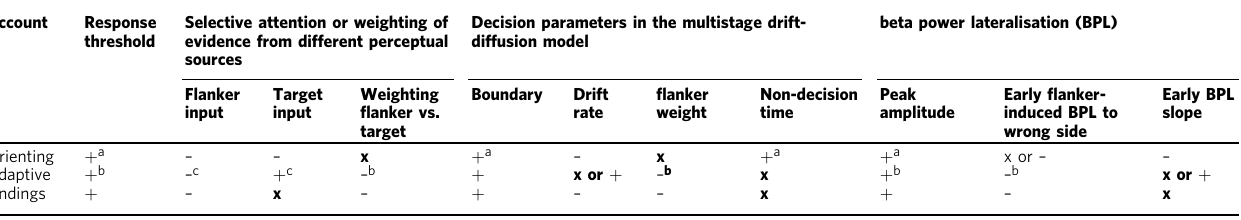
Table 1 Predictions of different accounts of post-error adjustments at a mechanistic level, in the framework of the multistage drift-diffusion model, and for beta power